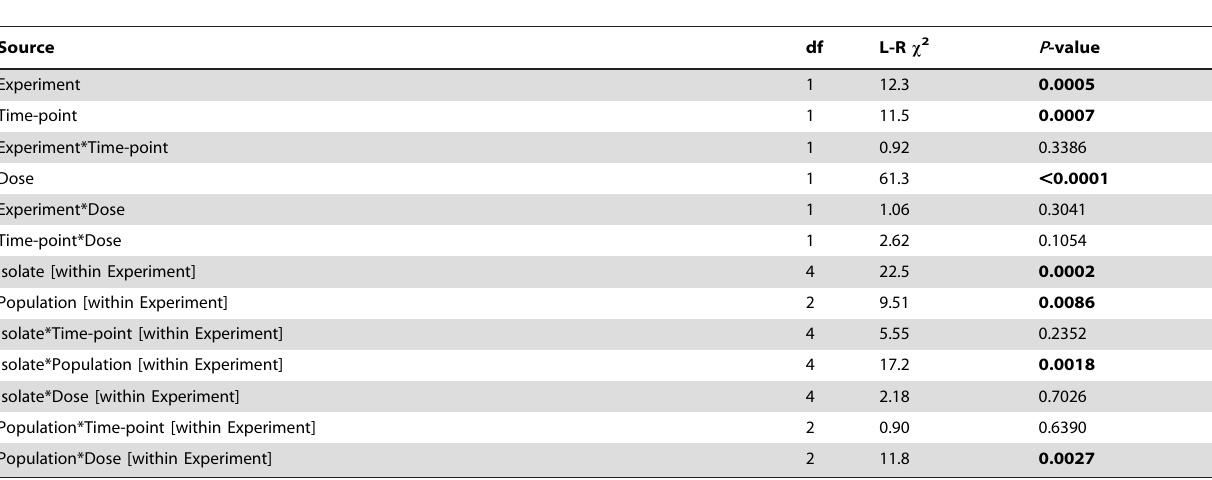
Table 1. Multifactorial logistic regression of infection